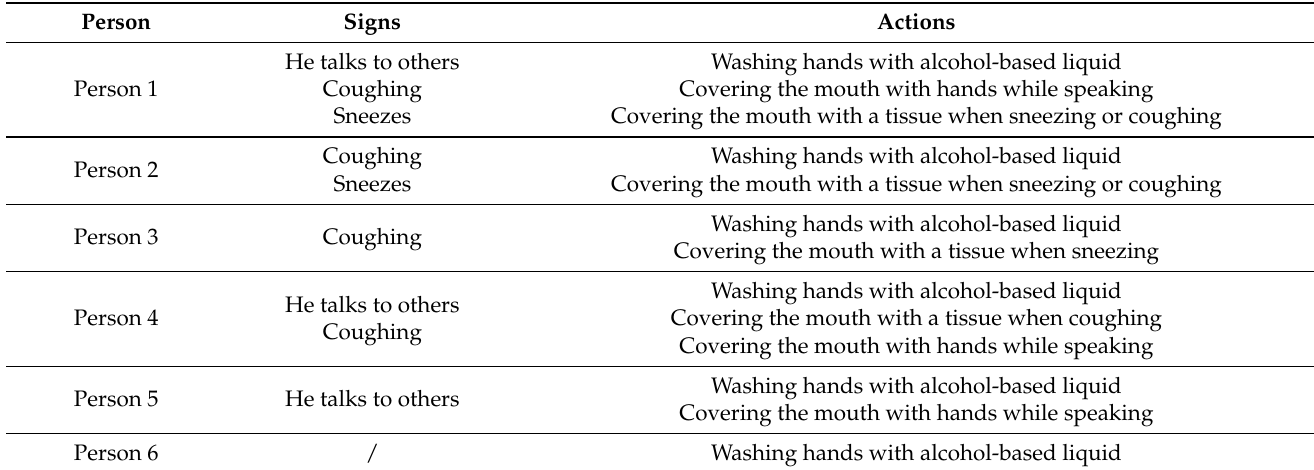
Table 6. Signs and actions of the third